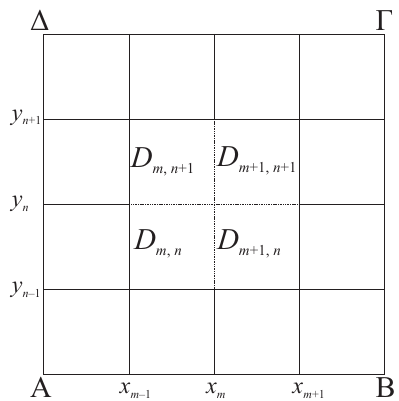
Figure 1. Domain for fractal interpolating surfaces over rectangular lattice and possible